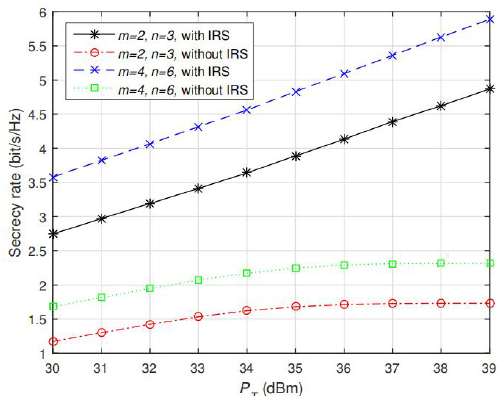
Figure 4. Average secrecy rate of intelligent reflecting surface (IRS)-assisted case using AO algorithm and no-IRS case using optimal solution in [6] under different settings of m = 2,4 and n = 3,6. P T is fixed at 30 dBm.